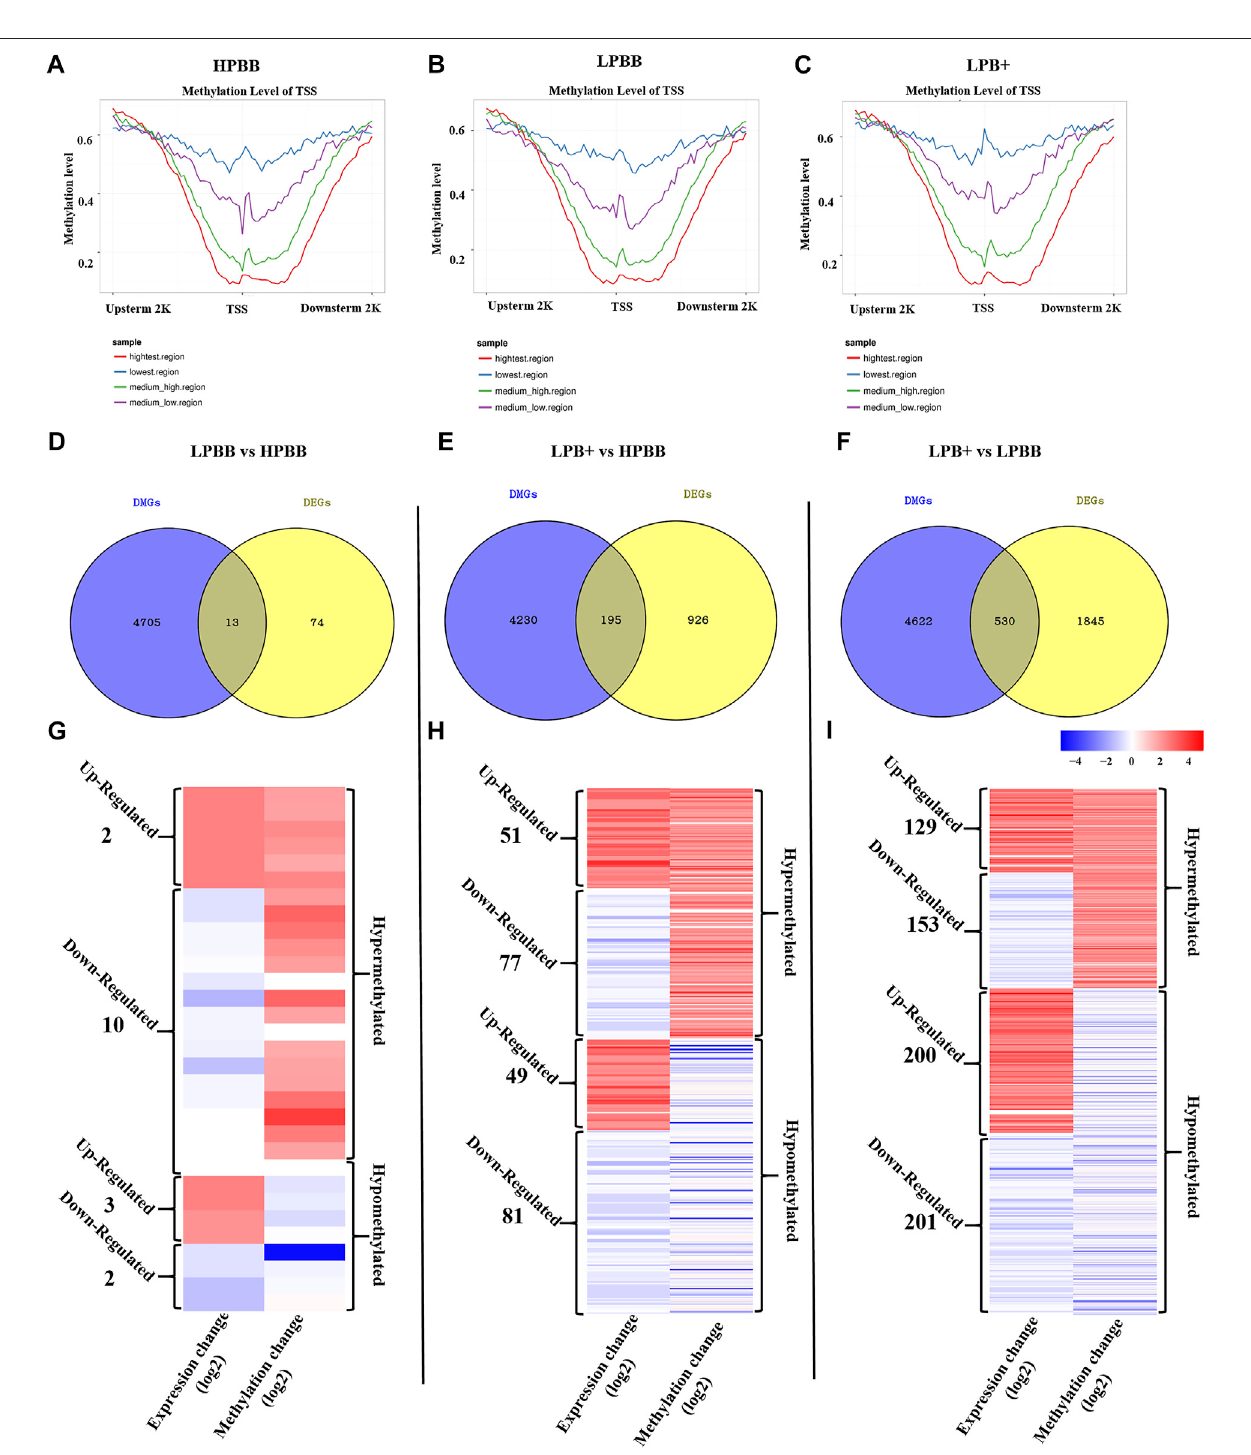
FIGURE7| IntegrativeanalysisoftheDNAmethylome andtranscriptomeintheovariesofdifferentgroups. (A – C) DNAmethylationleveldistribution aroundTSSof four levels of gene expression in the different groups. (D – F) Venn diagram shows the common DMGs and DEGs. (G – I) Heatmap showing the differentially methylated levels and corresponding genes change in the different comparison groups.